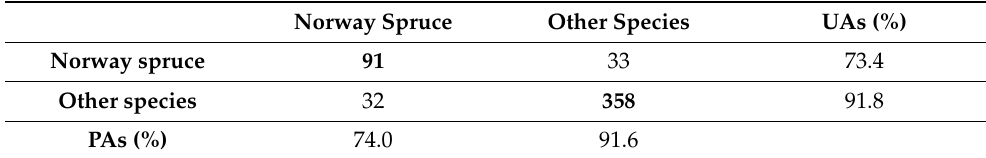
Table 4. Confusion matrix for the best combination of wSVM parameters over the 3-fold cross validation. Numbers in bold are the diagonal of the matrix.